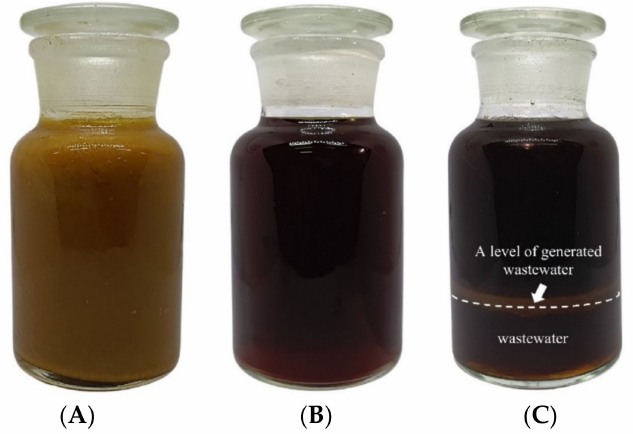
Figure 6. Production steps of biodiesel using batch process esterification ( A ) sludge palm oil, ( B ) het- erogeneous catalytic reaction esterified oil, and ( C ) homogeneous catalytic reaction esterified oil (top layer) and generated wastewater (bottom